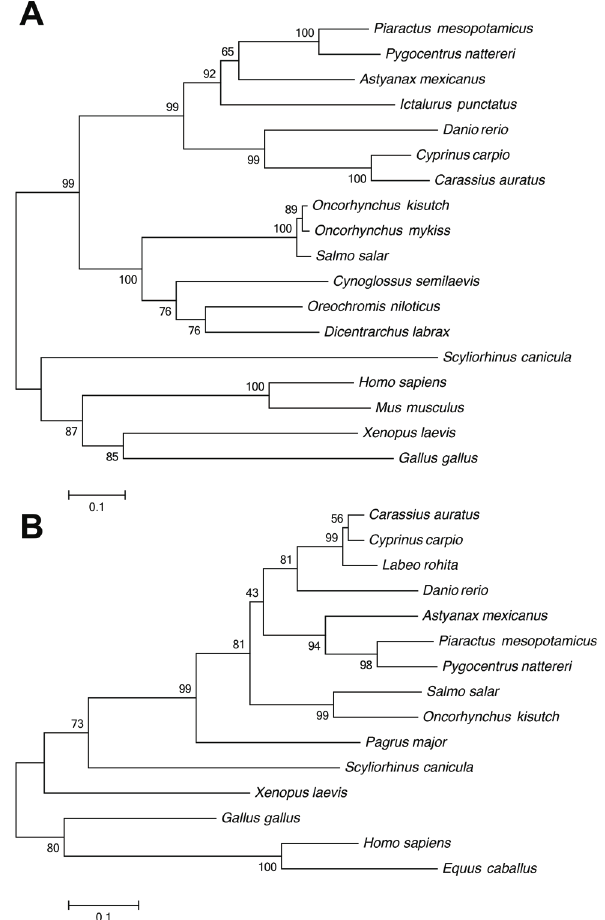
Figure 4 - Neighbor Joining phylogenetic analysis comparing the com- plete amino acid sequences of pmIL-1 (cid:2) (A) with Pygocentrus nattereri XP_017549212, Astyanax mexicanus XP_022536473, Ictalurus punctatus NP_001187148, Danio rerio AAQ16563, Cyprinus carpio CAC19888, Carassius auratus CAD12102, Oncorhynchus kisutch